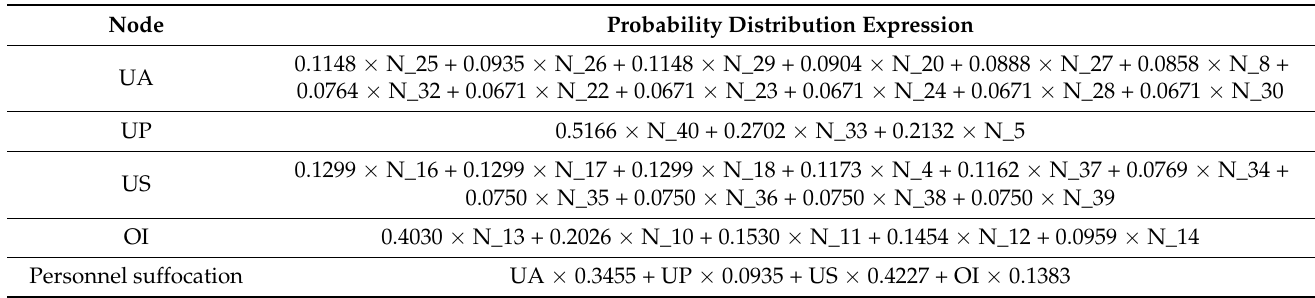
Table 7. Probability distribution expression for intermediate nodes and the top